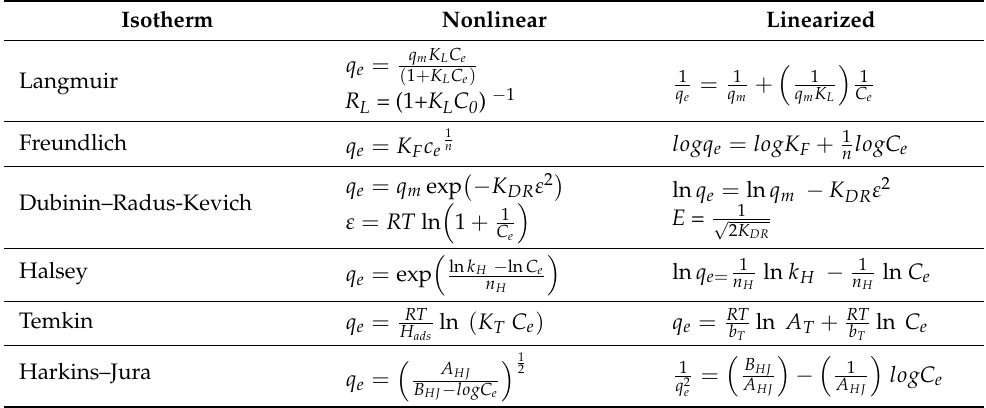
Table 3. Mathematical expressions of the nonlinear and linearized two-parameter isotherm